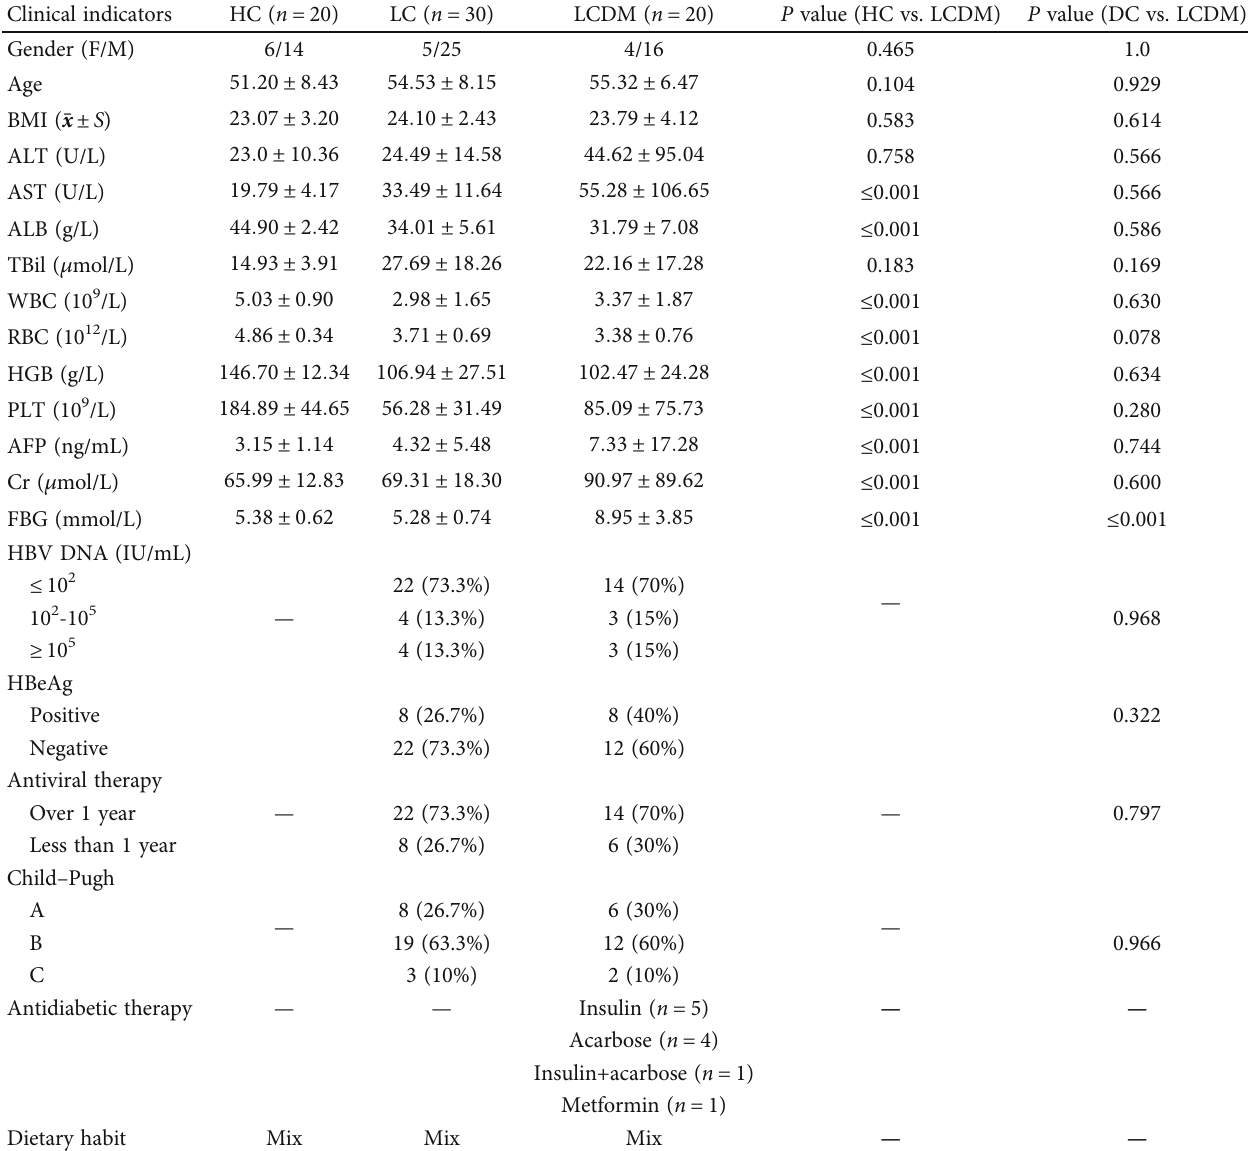
Table 1: Clinical characteristics of the enrolled